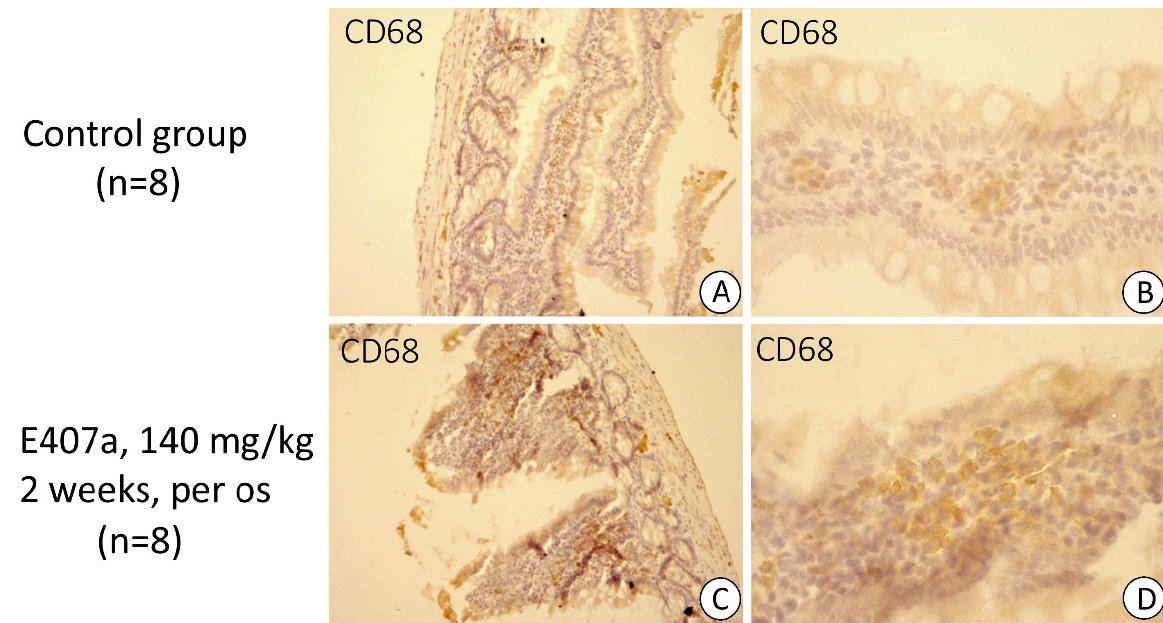
Figure 2. Immunostaining for С D68 (brown stain) in the small intestine of control animals (( A ), 100×; ( B ), 400×) and rats treated with E407a for two weeks (( C ), 100×; ( D ), 400×). Moderate amounts of CD68 + cells (macrophages) are observed in control samples. Exposure to E407a results in an increase in the number of CD68 + cells in the lamina propria.